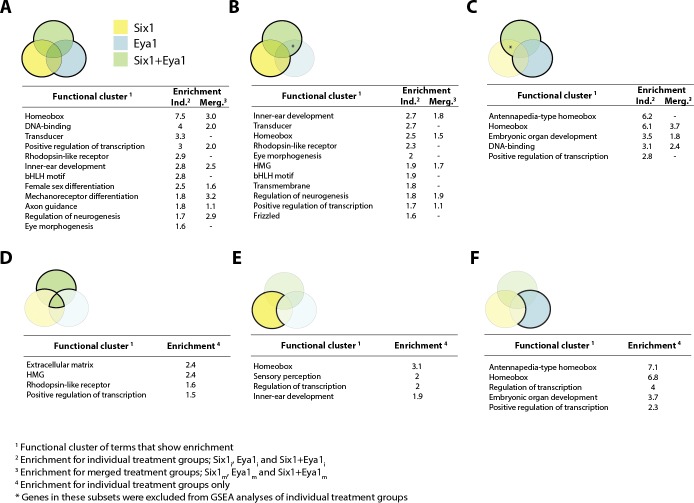
Gene set enrichment analysis (GSEA) showing enriched clusters of functional terms for up-regulated genes in different treatment groups.In each case, treatment groups considered are highlighted and outlined in bold in the accompanying Venn diagram. Yellow colouring indicates Six1 treatment; blue shows Eya1 and green Six1+Eya1. Enrichment scores ≥1.5 are reported for individual treatment groups (Ind.) and, where available, ≥0.5 for merged treatment groups (Merg.). (A) Up-regulated genes from all treatment groups included in analysis; (B) Six1 overexpression only; (C) Eya1 overexpression only. (D) Genes differentially expressed after overexpression of both Six1 and Eya1; (E) exclusively after Six1 overexpression; (F) exclusively after Eya1 overexpression.